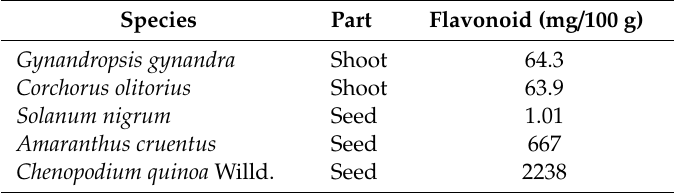
Table 6. Flavonoids content in some TLVs species. Values collected from Akubugwo et al. [162], Pa´sko et al. [163], Yang et al.